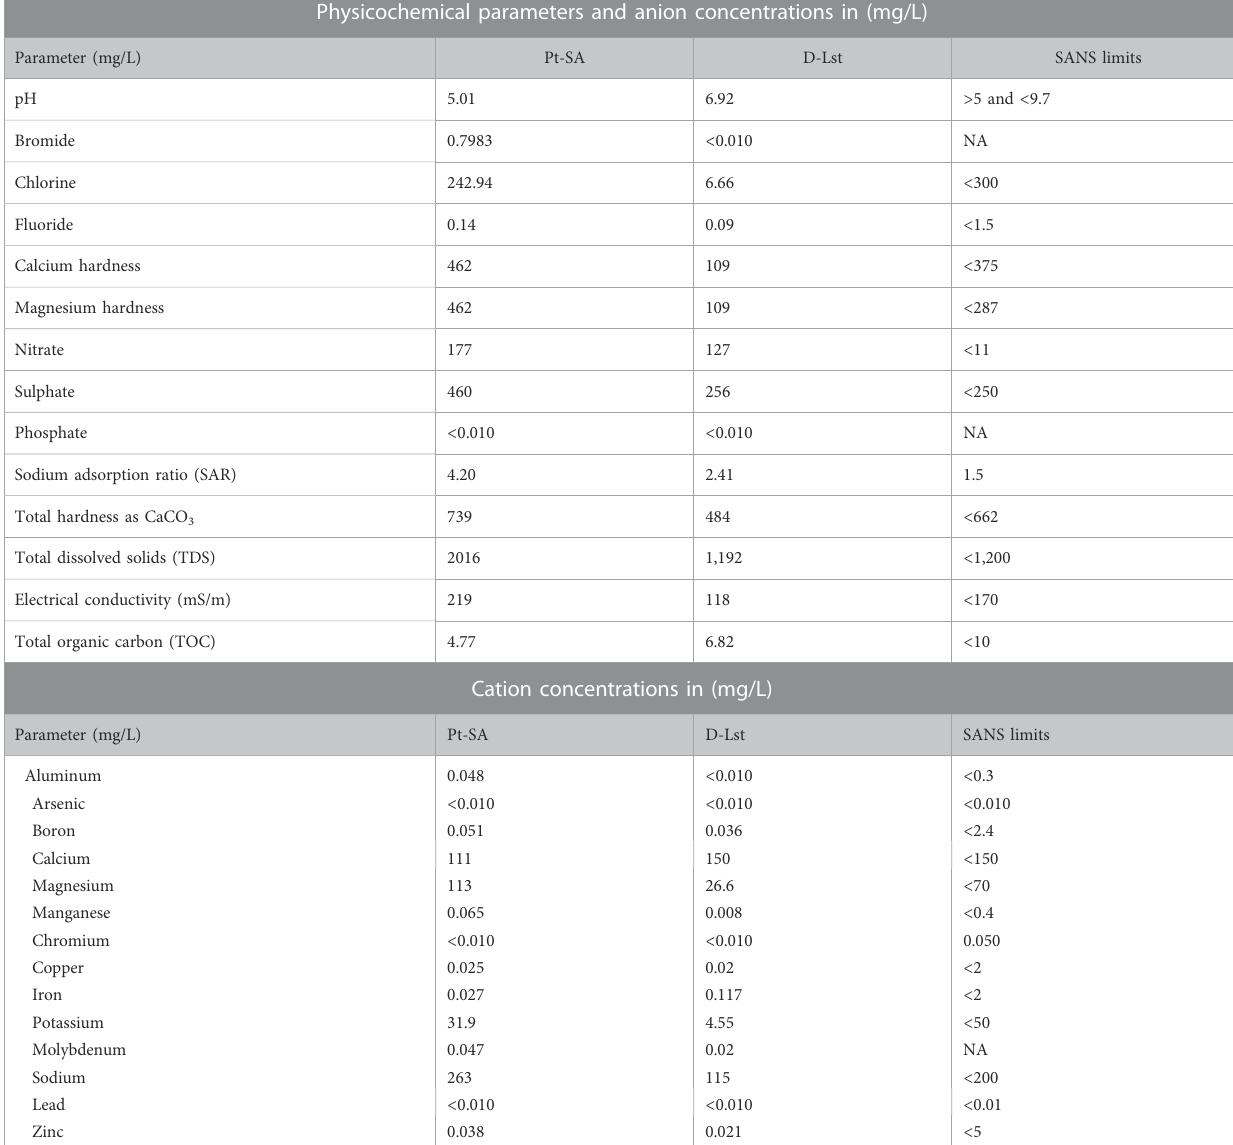
TABLE1Physicochemical parametersandanionandcationconcentrationsmeasuredinthecollectedminewastewatersamples,withvaluesabovetheSANSlimits highlighted in grey. Physicochemical parameters and anion concentrations in